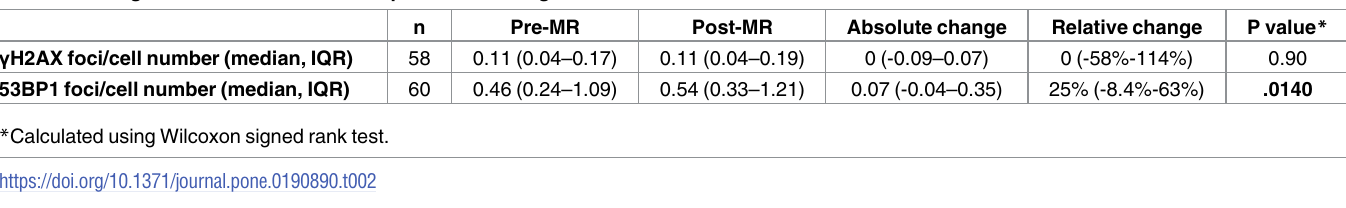
Fig 1. Individual changes in γ H2AX(A) and 53BP1(B) foci per cell following cardiac MR.